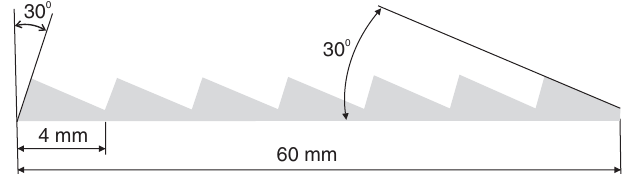
FIG. 2. SPR grating geometry.